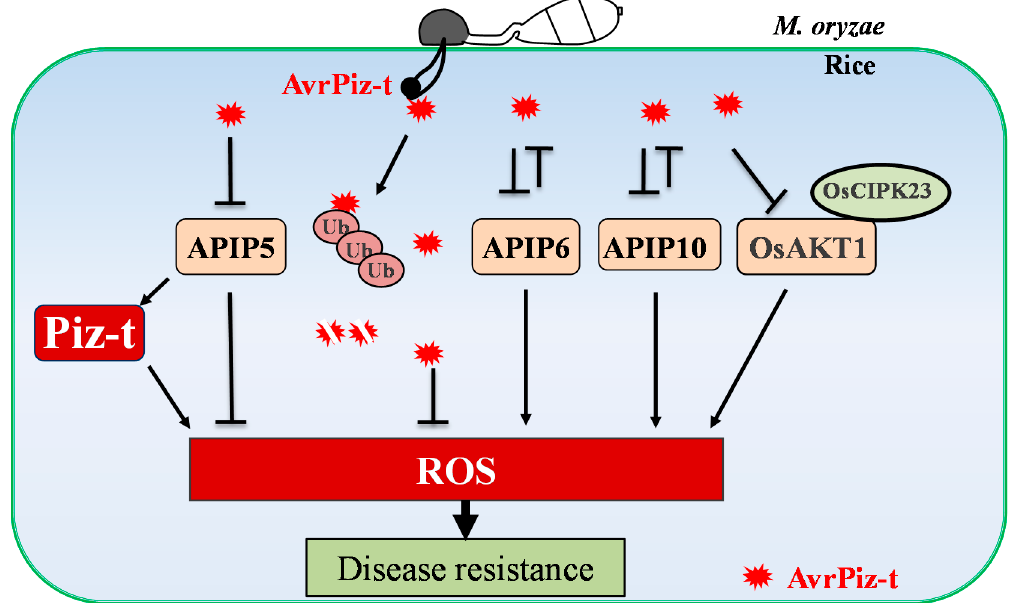
Figure 5. AvrPiz-t and AvrPiz-t targeted proteins regulate ROS accumulation during immunity. APIP5, APIP6, and APIP10 are AvrPiz-t interacting proteins. OsAKT1, which interacts with AvrPiz-t, is a rice plasma-membrane-localized K + channel protein. Silencing APIP6 , APIP10 , or OsAKT1 reduces the PMAP-induced ROS production. In contrast, silencing APIP5 leads to ROS